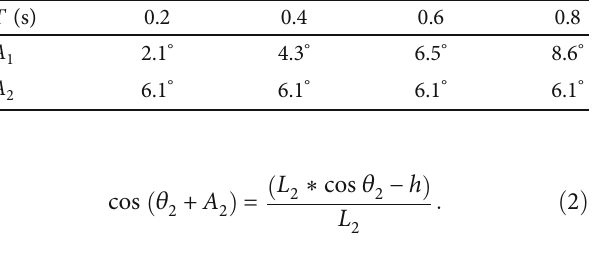
ffiffiffi p 3 m. v was mainly determined